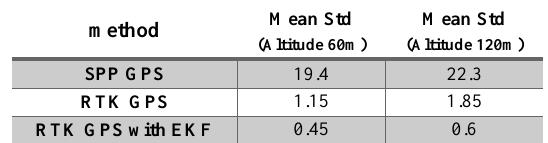
Table 4: Comparison of mean standard deviation geolocation results using 60m and 120m as UAV flight altitude, with respect to 3D dense reference